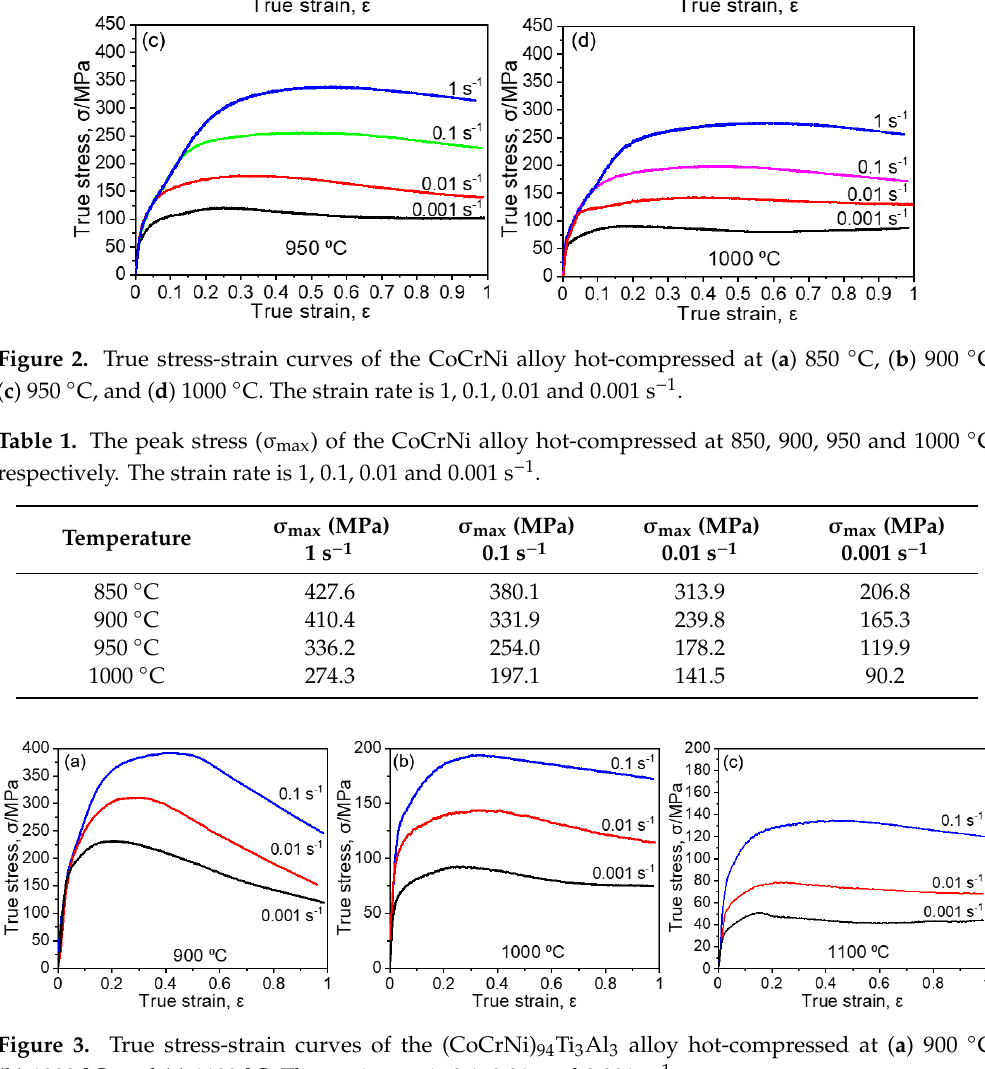
Figure 2. True stress-strain curves of the CoCrNi alloy hot-compressed at ( a ) 850 °C, ( b ) 900 °C, ( c ) 950 °C, and ( d ) 1000 °C. The strain rate is 1, 0.1, 0.01 and 0.001 s − 1 . Table 1. The peak stress ( σ max ) of the CoCrNi alloy hot-compressed at 850, 900, 950 and 1000 °C, respectively. The strain rate is 1, 0.1, 0.01 and 0.001 s − 1 .